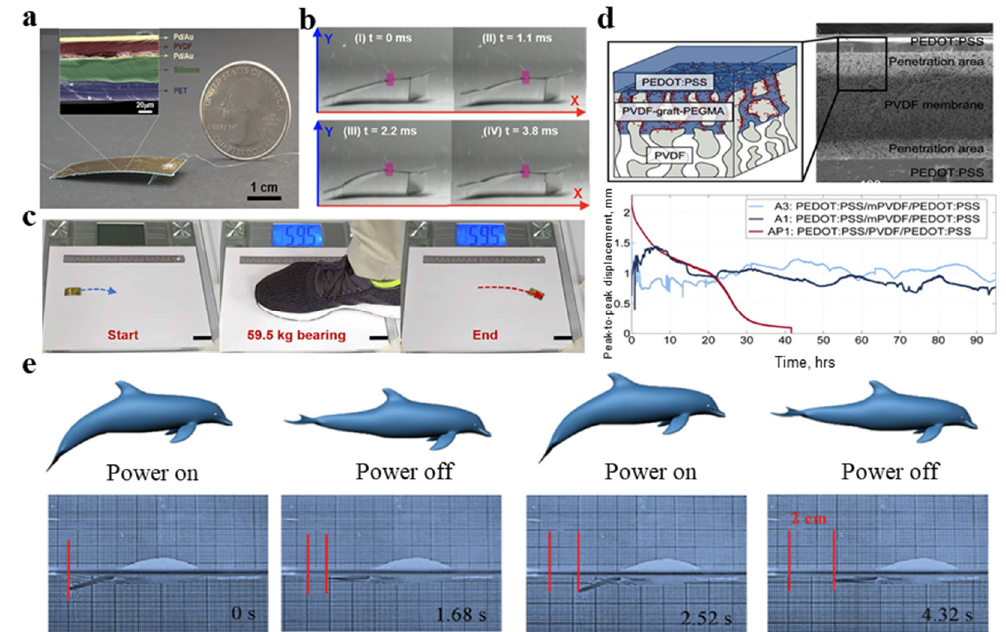
Figure 14. ( a ) Optical photo of the fabricated robot and the SEM image of the cross-sectional view of the prototype robot with different layers of materials [167] ; ( b ) images of prototype robot the movements in a driving cycled [167] ; ( c ) after bearing the weight of an adult’s footsteps (about one million times heavier than the robot), the system can continue to move [167] ; ( d ) the cross-sectional view of the hydrophilic PVDF-graft-PEGMA [168] ; and ( e ) a fish-like robot to imitate fish swimming [169]. Table 3. Different fabrication methods, fabricated material and sensitivity of various sensors.